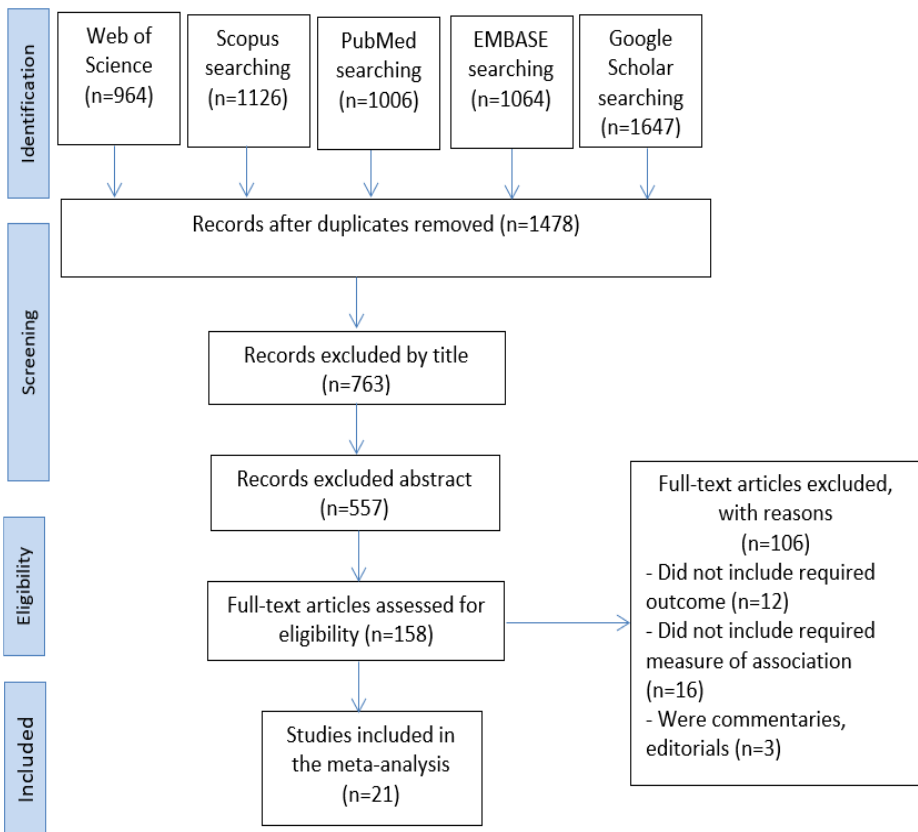
Figure 1. The PRISMA flowchart for the process of selecting and identifying studies.